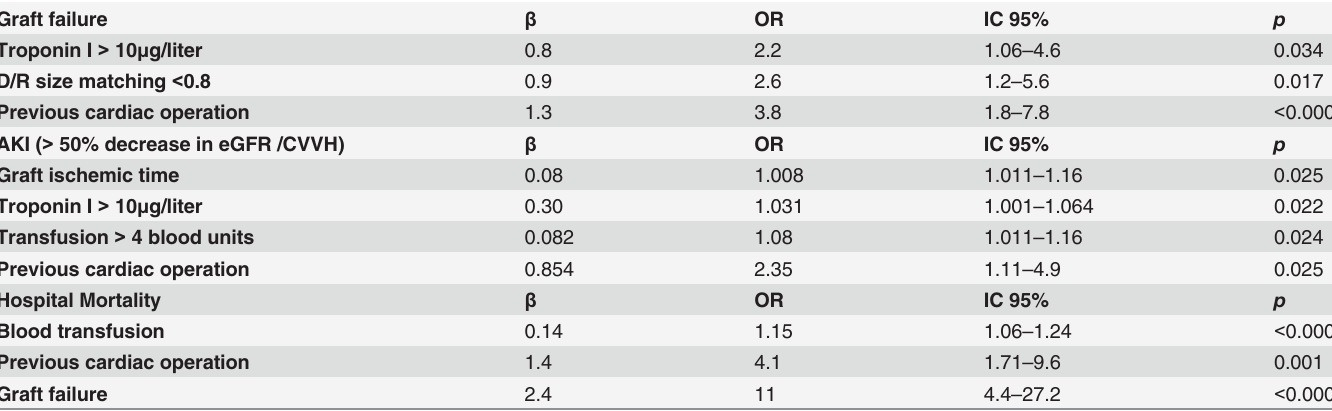
Table 4. Logistic regression modelling for graft failure, AKI, and Hospital Mortality.